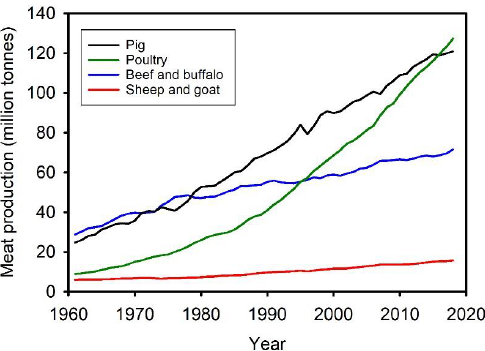
Figure 1. World meat production (1961–2020). Data from Ritchie and Roser [7,9].